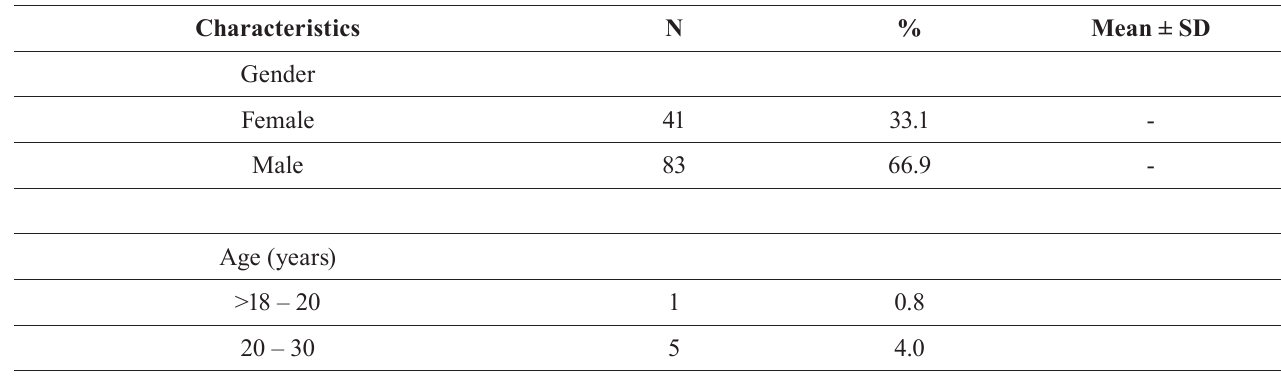
TABLE IV - Sociodemographic characteristics of the participants in the evaluation of quality of life in the city of Cascavel – PR